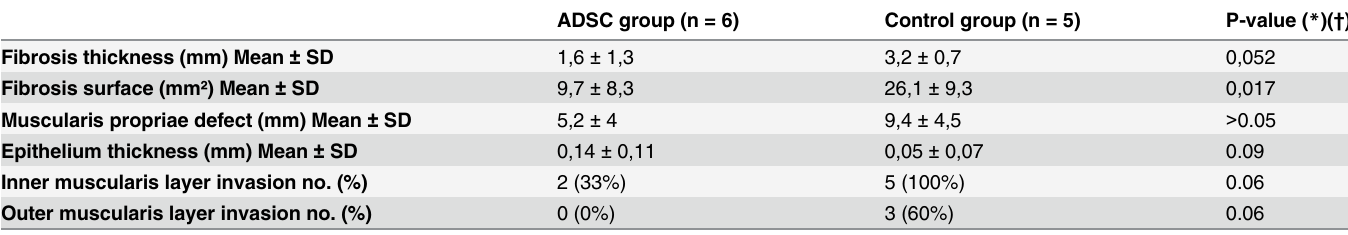
Table 2. Histologic results on day 28.